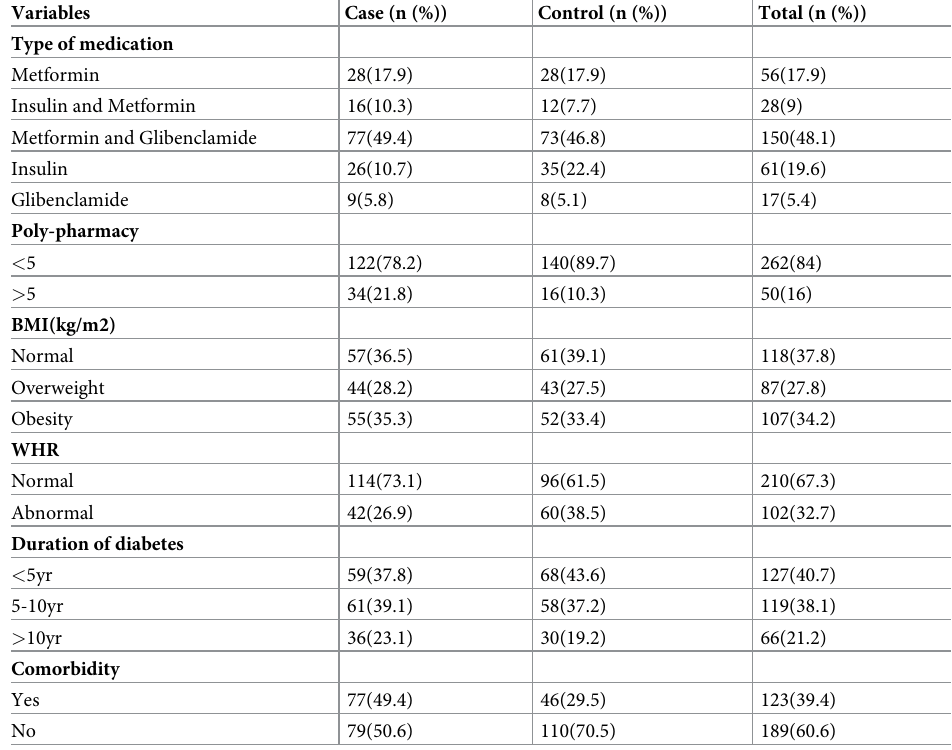
Table 2. Clinical characteristics of adult patients with type 2 diabetes mellitus on follow-up at the diabetic clinic Gamo and Gofa zone public hospitals south Ethiopia,